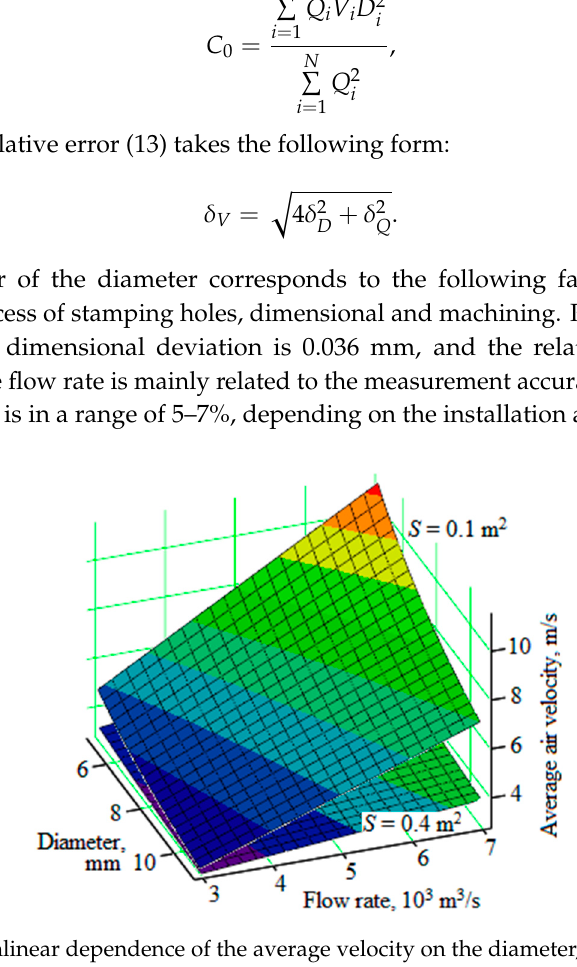
Figure 7. The nonlinear dependence of the average velocity on the diameter, flow rate, and area.